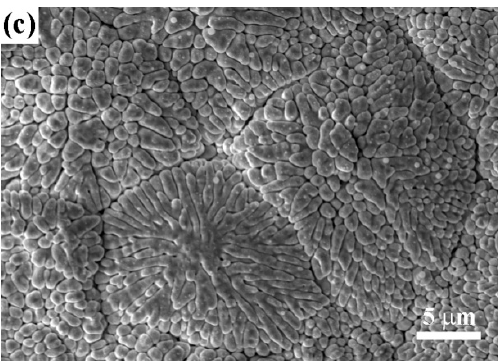
Figure 4. ( a ) Surface morphology, ( b ) surface roughness, and ( c ) high magnification surface micrograph of the dotted unit in the dotted specimen.